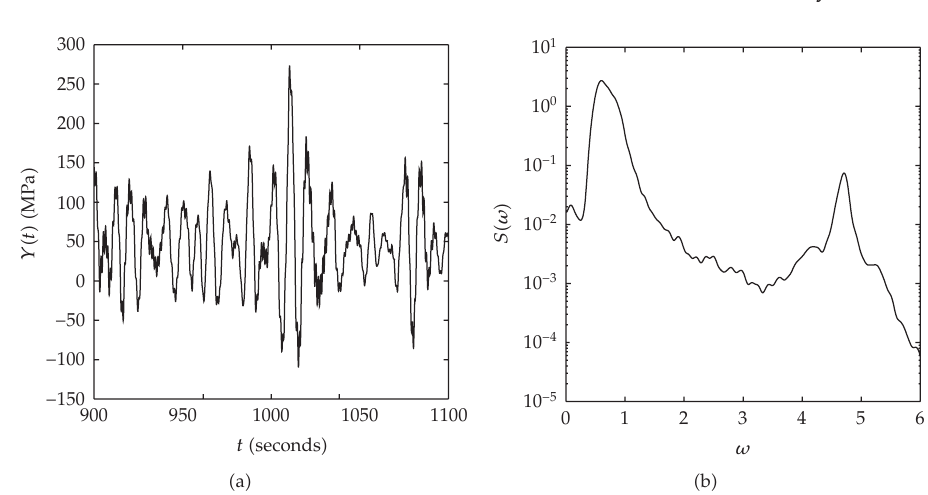
Figure 1: Example 5.1: (cid:2) a (cid:3) A part of the measured stress. (cid:2) b (cid:3) An estimate of the spectral density for the measured